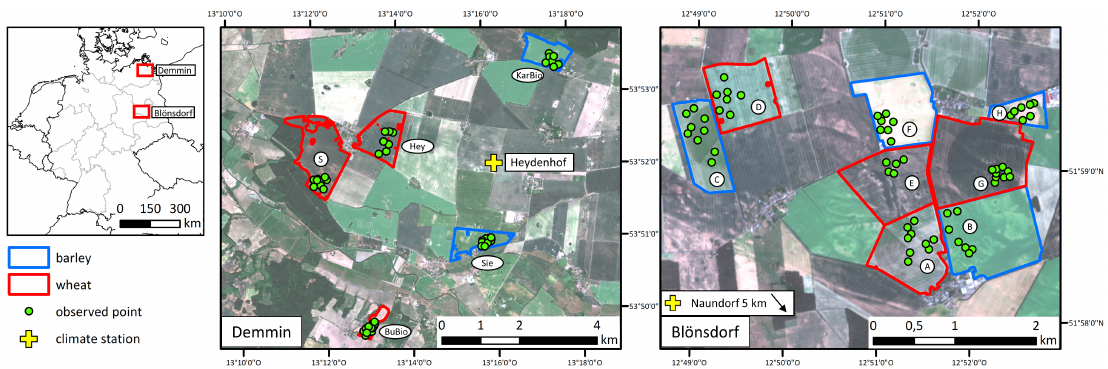
Figure 1. Location of the two test sites DEMMIN and Blönsdorf in Germany ( left ) and observed wheat and barley fields with measurement points in 2017 and 2018 in DEMMIN ( center ) and Blönsdorf ( right ). 3. Data